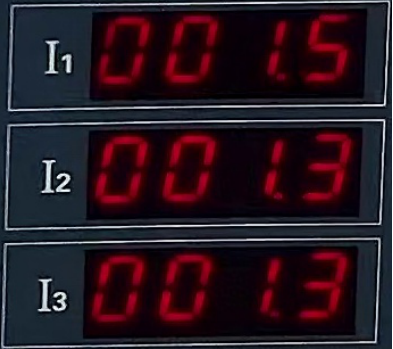
Figure 9. Locate the acquired dial area from original image